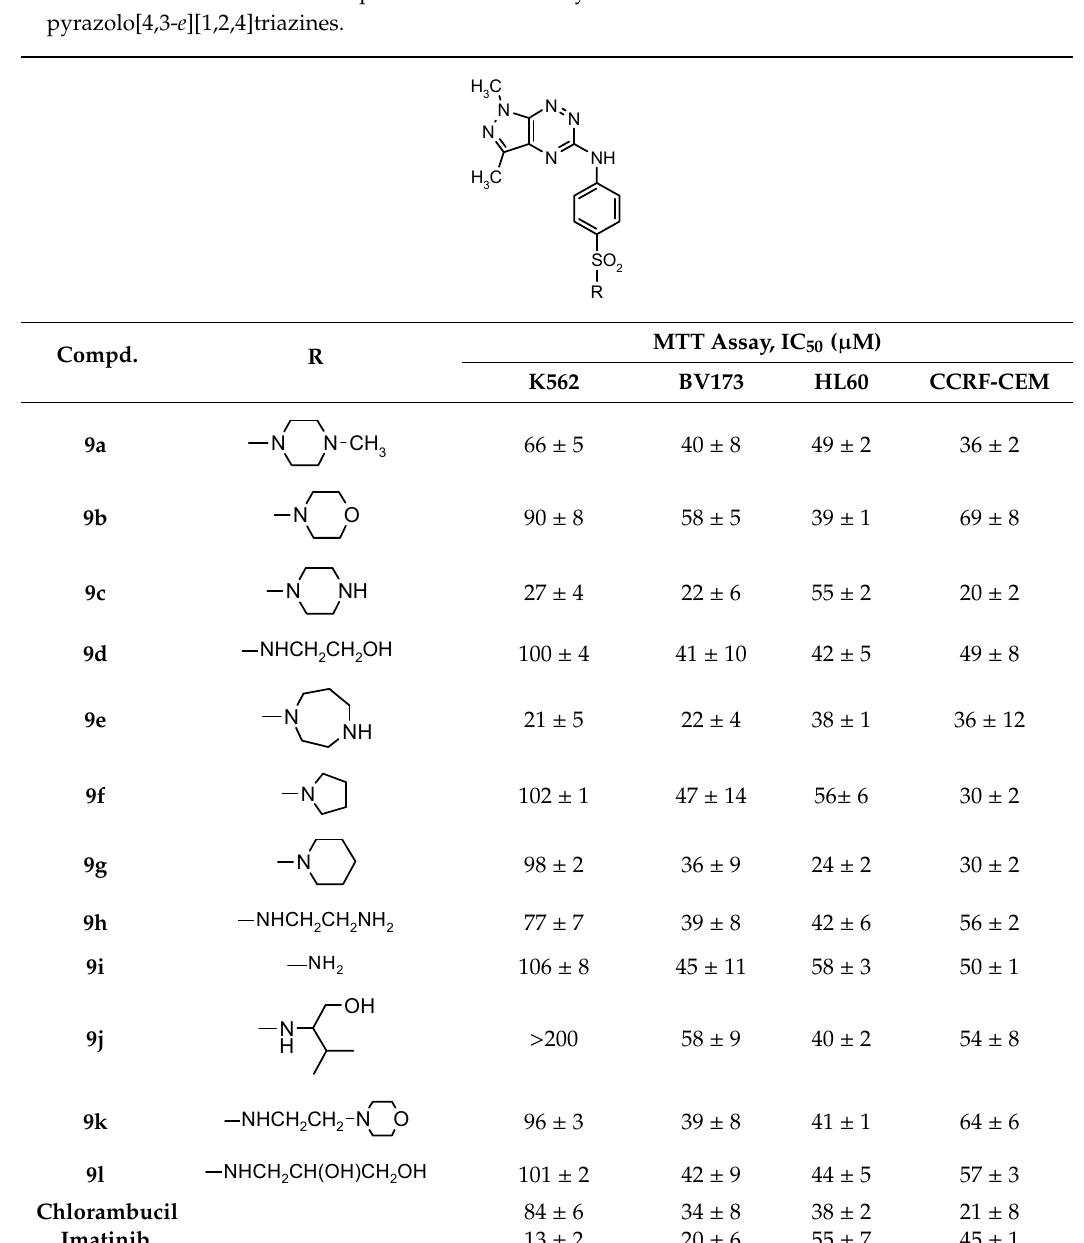
Table 3. In vitro antiproliferative activity of new sulfonamide derivatives of pyrazolo[4,3- e ][1,2,4]triazines.